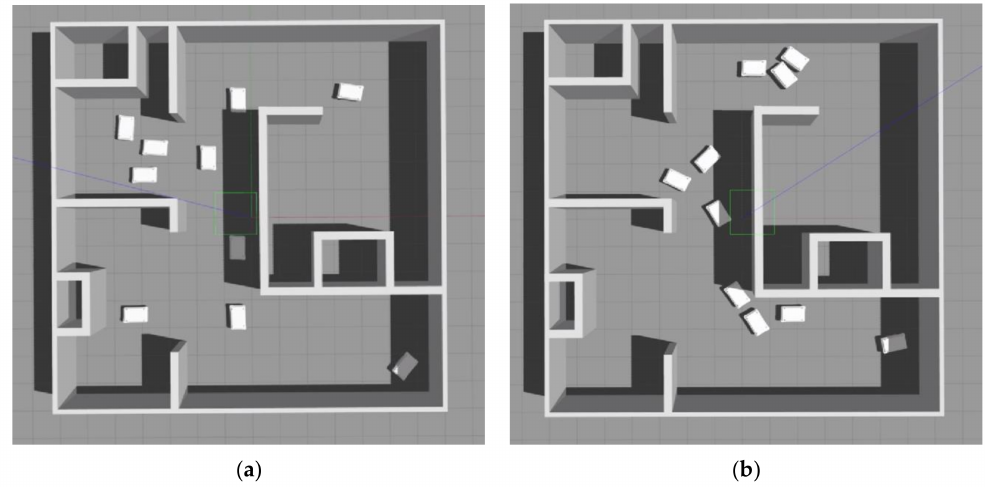
Figure 6. Simulation experiments for validation of the proposed method: ( a ) proposed approach; ( b ) baseline approach.